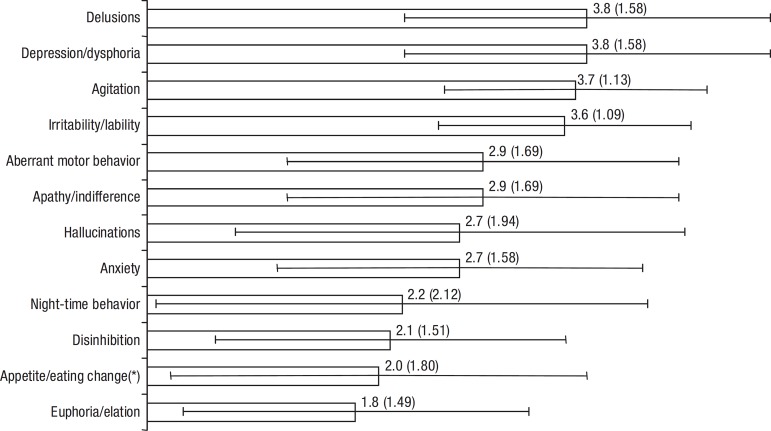
CDI by Symptom - m(SD).